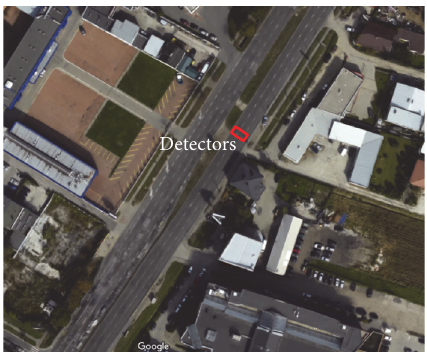
Figure 2: Measurement site, Al. Krakowska, Warsaw, Poland, (c) Google